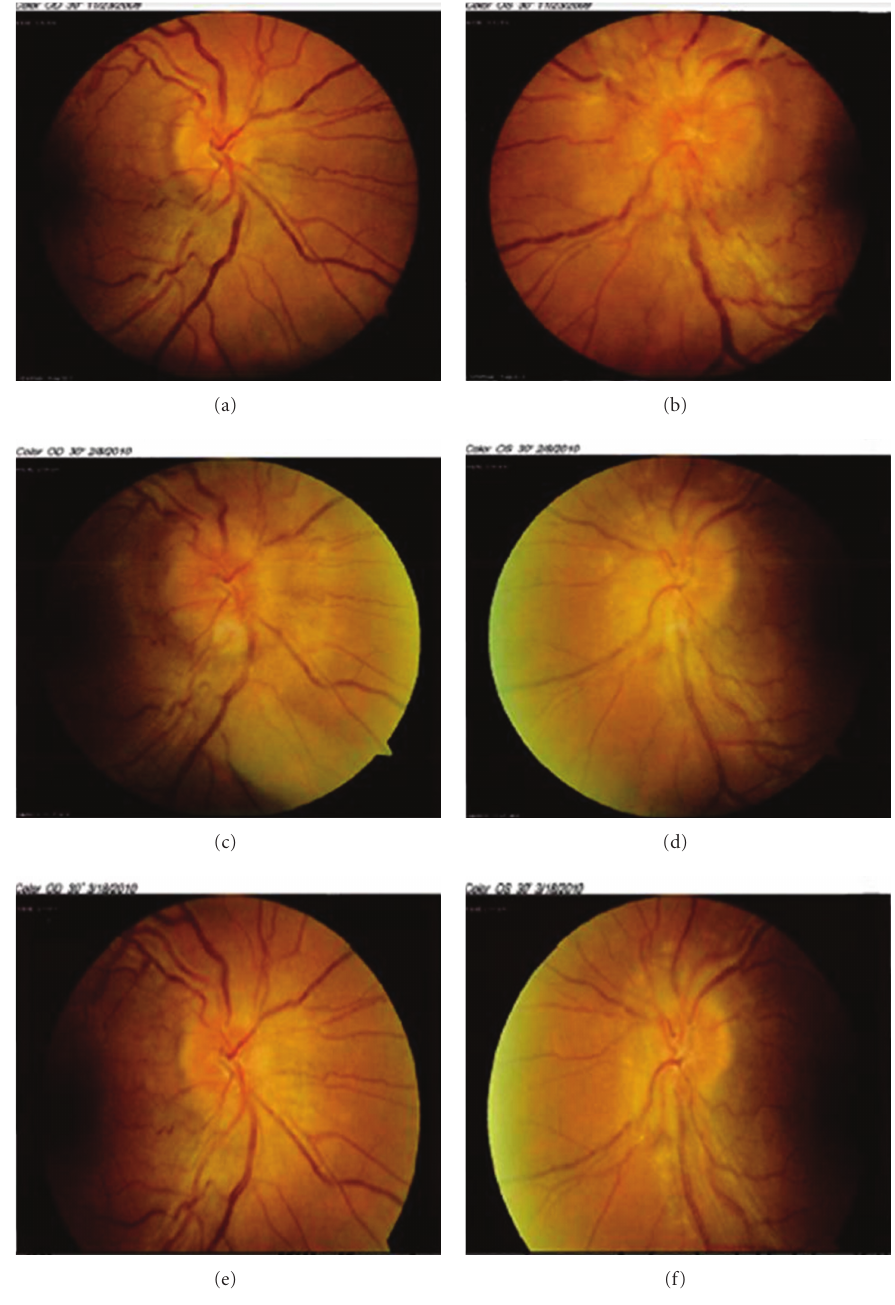
Figure 3: Composite of fundus appearances over time. Fundus photos showing extent of disc edema over time: at presentation (a, b), pretreatment with highest-grade edema (c, d), and posttreatment (e,